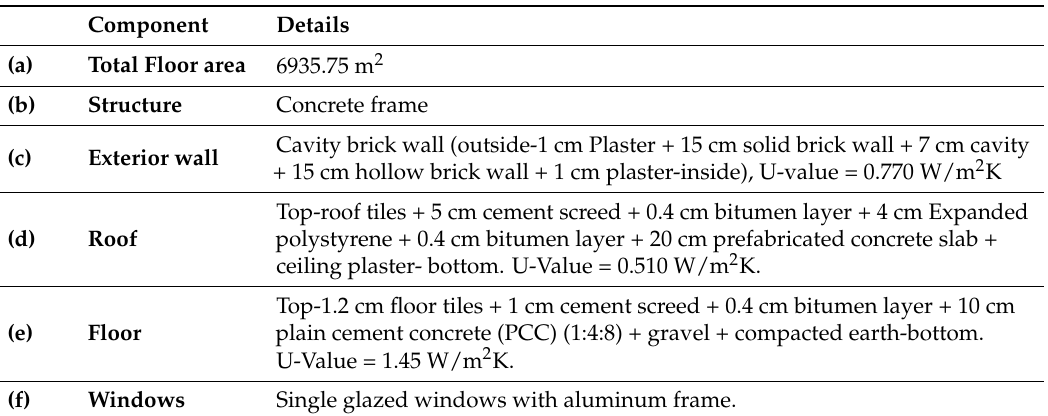
Table 2. Base-case model material